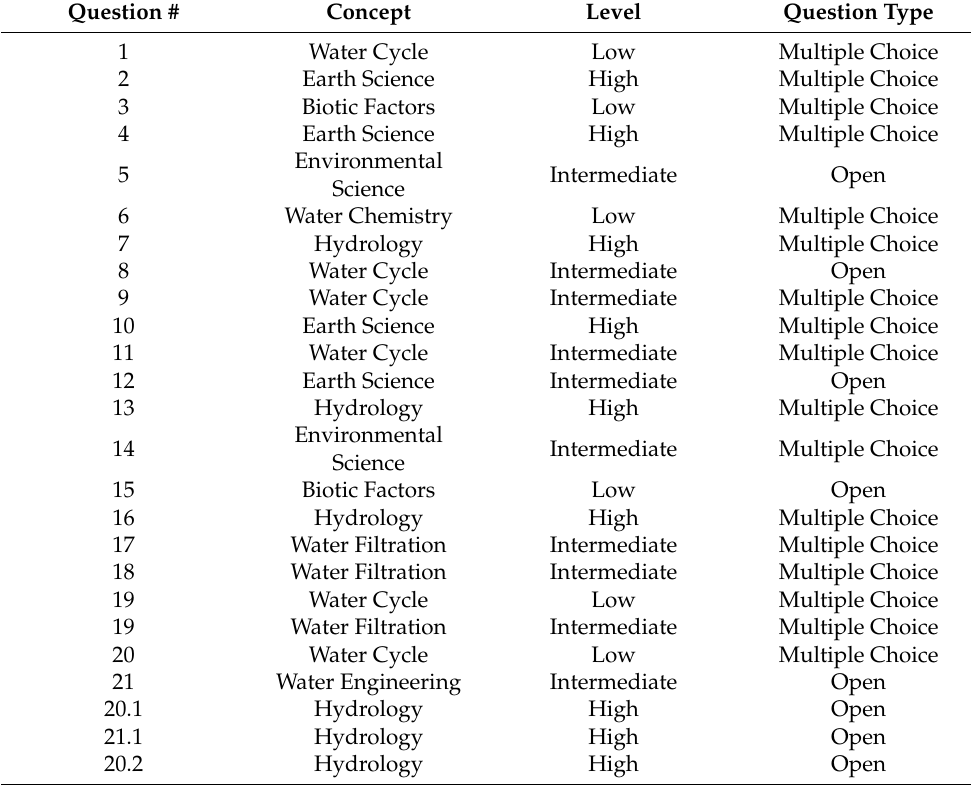
Table 4. Pre and Post Test Questions by Concept